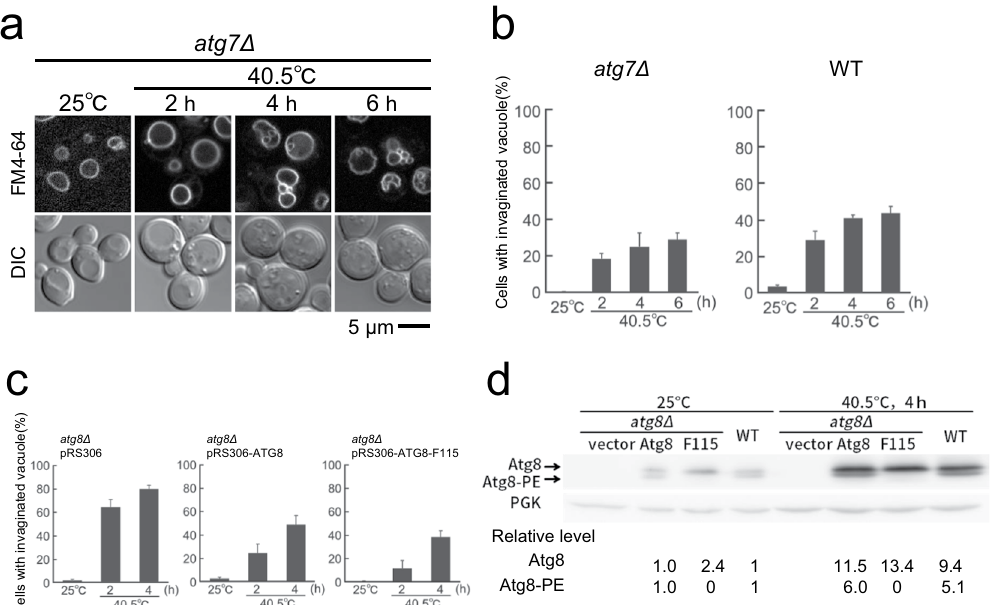
Figure 3. Lipidation-independent function of Atg8 for suppressing vacuole invagination after heat stress. ( a ) FM4-64 staining of vacuolar morphology of atg7 Δ mutants at 25 °C and after the indicated times at 40.5 °C. Because FM4-64 fluorescence was fainter in cells at 25 °C than in cells after heat stress, the contrast of the images of cells at 25 °C was enhanced. Images with the same contrasts at 25 °C and 40.5 °C are shown in Fig. S5a. ( b ) Quantification of invaginated structures of vacuolar membrane in (A). The mean values of the ratio and standard errors (SE) are shown. ( c ) Quantification of invaginated structures of vacuolar membrane in atg8 Δ cells (pRS306) and atg8 Δ cells expressing Atg8 or Atg8-F115. SEs are shown. Statistical significance: p = 0.01 and 0.006 for both-sided t-test for atg8 Δ cells (pRS306) vs. atg8 Δ cells (pRS306-ATG8-F115) both at 2 and 4 h, respectively at 40.5 °C. Statistical significance was not observed (p > 0.05) for atg8 Δ (pRS306-ATG8) vs. atg8 Δ (Atg8-F115) cells both at 2 and 4 h at 40.5 °C, respectively. ( d ) Expression of Atg8 and Atg8-F115. Western blot analysis was performed using cells in (C) and wild-type cells at 25 °C and at 40.5 °C for 4 h, with anti-Atg8 and anti-PGK1 antibodies. Quantification was shown at the bottom. Uncropped western blotting results are presented in Fig.